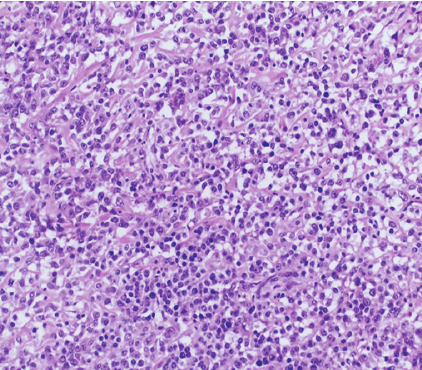
Figure 1: Small round cell osteosarcoma. The tumor is composed of a uniform population of round cells with focal production of osteoid matrix (H&E). Observation in brightfield. Original magnification: